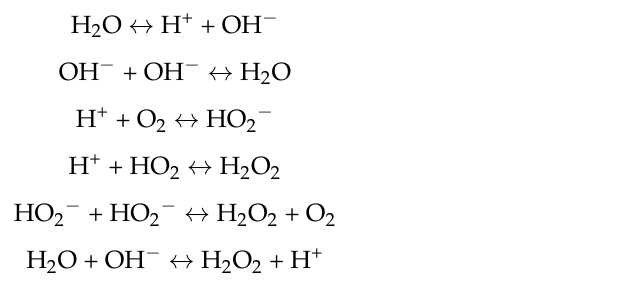
Figure 7. Encapsulation mechanism of citronella oil in Alg/Carr in the presence of ultrasonic irradi- ation .